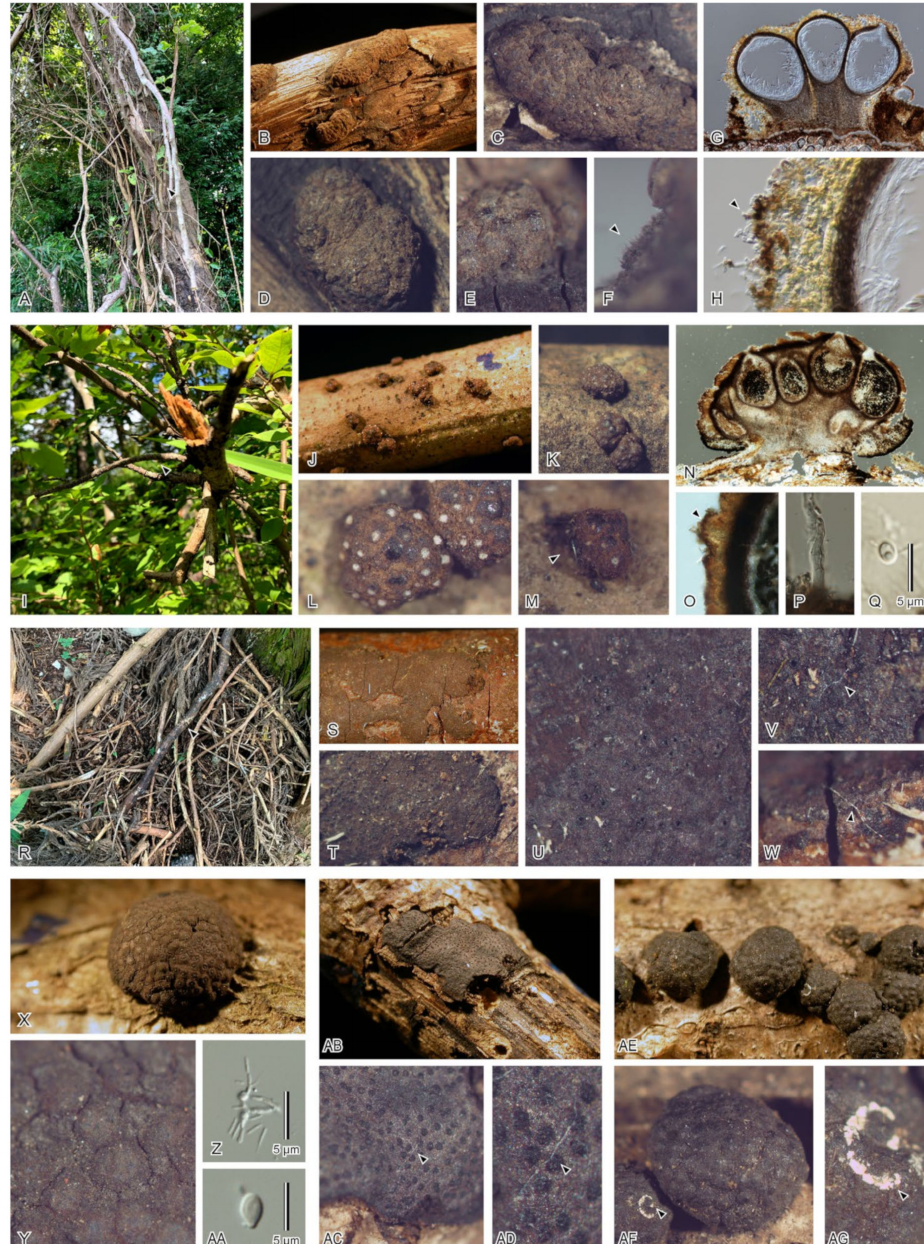
Figure 1. Habitats of the Xylariales fungi used in this study. ( A – H ) Field and microscopic observation of the sample AM002. ( A ) Habitat. Samples were collected from the trapped twigs (indicated by arrowhead). ( B – F ) Surface of the ascomata. SCIF occurring on the stroma in ( F ) (indicated by an arrowhead). ( G ) Ascomata in longitudinal section. ( H ) Melanized hyphae externally occurring on the host fungus peridium (indicated by an arrowhead). ( I – Q ) Field and microscopic observation of the sample AM003. ( I ) Habitat. Samples were collected from the dead twigs (indicated by an arrowhead). ( J – M) Surface of the ascomata. SCIF occurring on the stroma in ( M ) (indicated by an arrowhead). ( N ) Ascomata in longitudinal section. ( O ) Melanized hyphae occurring on the peridium (indicated by arrowhead). ( P ) Sympodial conidiogenous cell occurring on the peridium. ( Q ) Unidentified conidium. ( R – W ) Field and microscopic observation of the sample AM007. ( R ) Habitat. Samples were collected from the fallen dead twigs (indicated by an arrowhead). ( S – W ) Surface of the ascomata. SCIF occurring on the stroma in ( V , W ) (indicated by an arrowhead). ( X – AA ) Microscopic observation of the sample WS34. ( X – Y ) Surface of the ascomata. ( Z ) Basidiospore of Ustilaginomycotina on the peridium. ( AA ) Acrodontium -type conidia on the peridium. ( AB – AD ) Microscopic observation of the sample WS35. Surface of the ascomata. SCIF occurring on the ascomata in ( AC , AD ) (indicated by the arrowhead). ( AE – AG ) Microscopic observation of the sample WS36. Surface of the ascomata. SCIF occurring on the ascomata in ( AF , AG ) (indicated by an